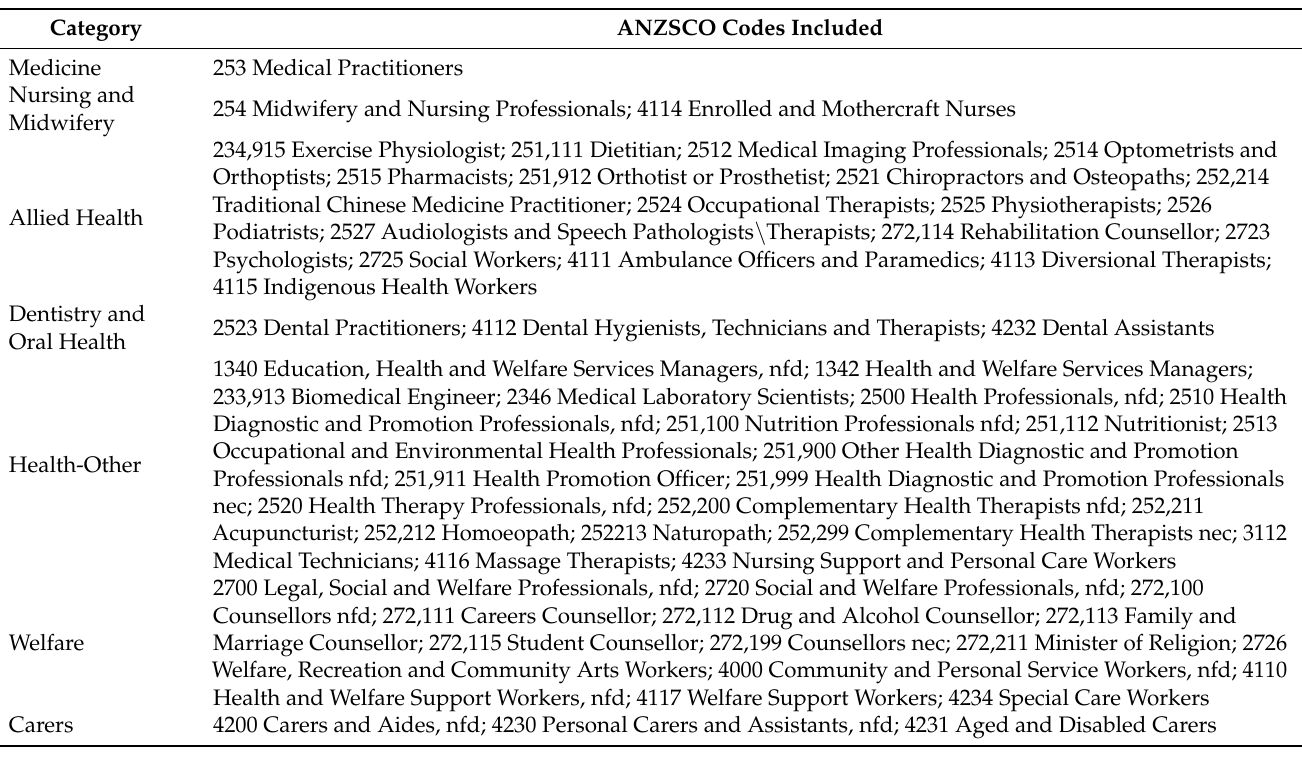
Table A1. Categorisation of the health, welfare and care workforce in